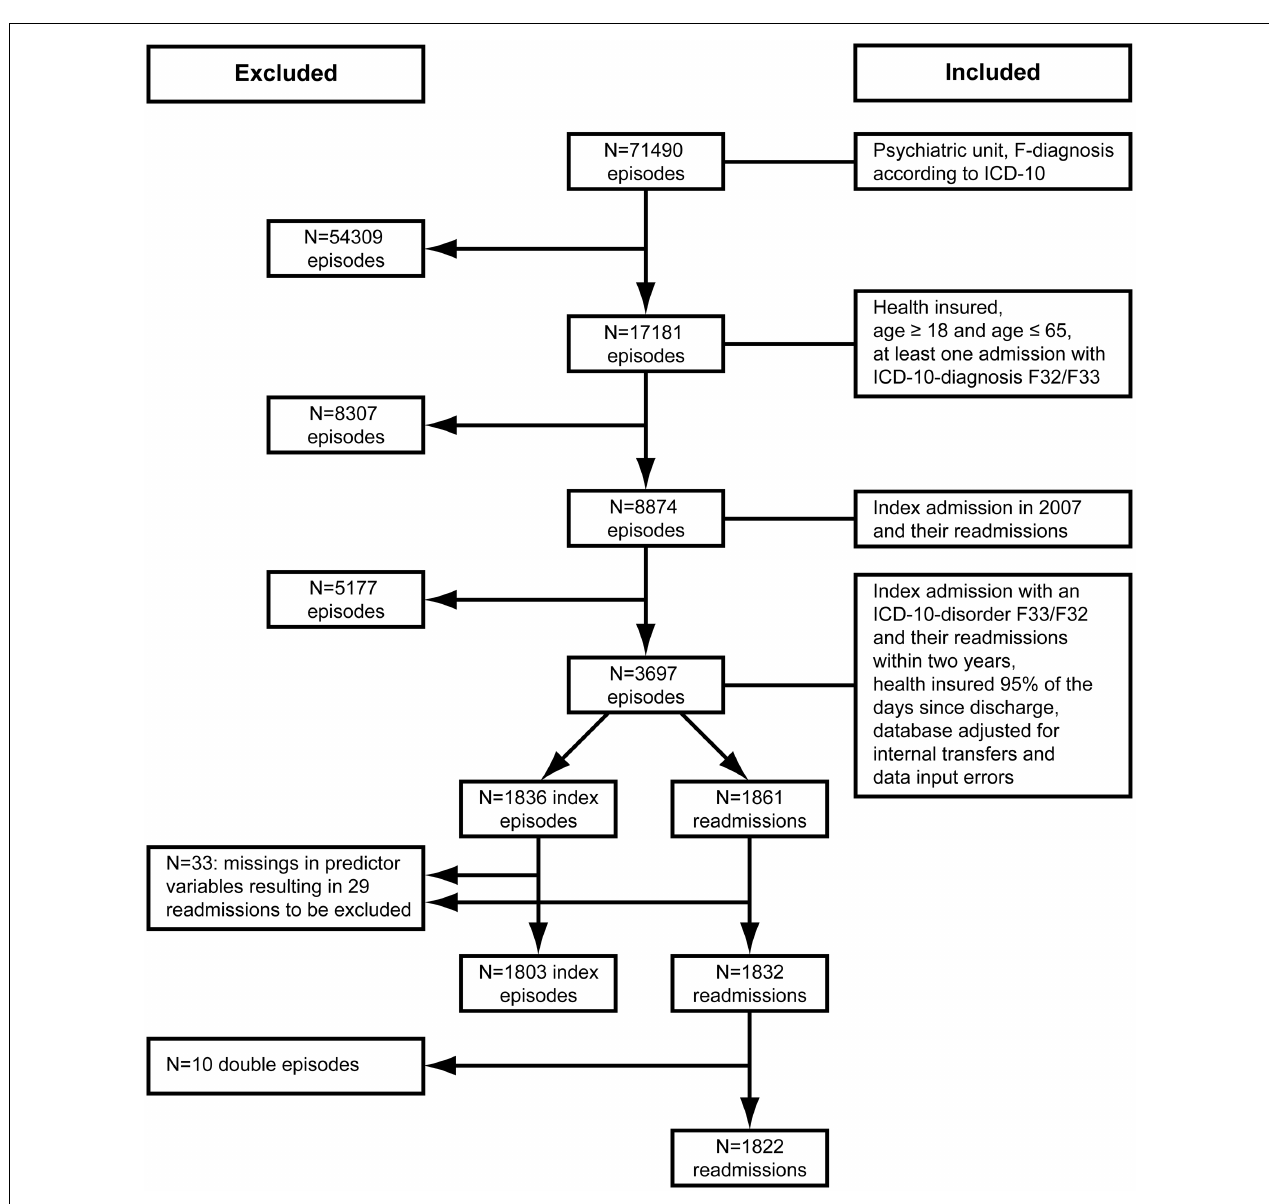
FIGURE 1 | Sample selection process referring to inpatient episodes